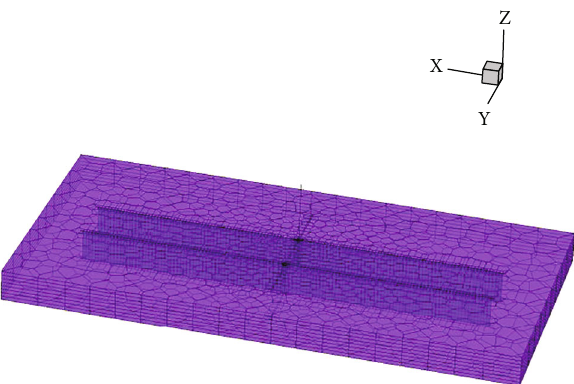
Figure 7: The geological model for Case 4.